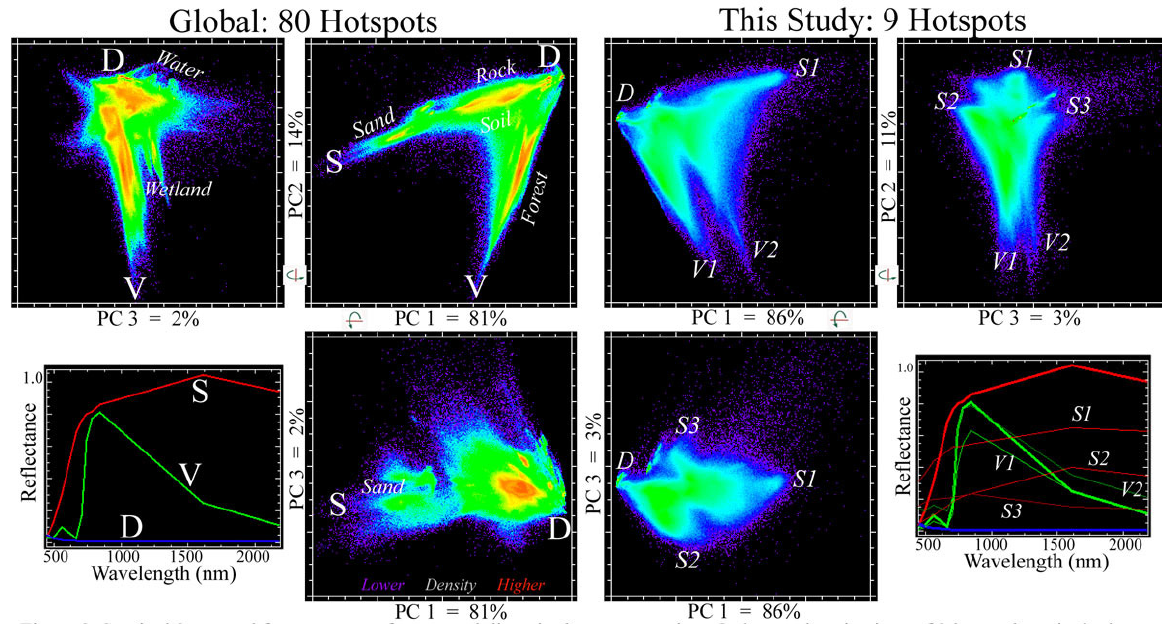
Figure 2. Sentinel 2 spectral feature spaces for spectral diversity hotspot mosaics. Orthogonal projections of three low-order principal component distributions are bounded by substrate, vegetation, and dark spectral endmembers at apices spanning spectral mixtures within the triangular space. The 9X larger, more diverse global mosaic has a more distinct internal structure with multiple clusters and mixing continua denoting different types of land cover. Both spaces are effectively 2D, with >95% of variance on the PC1-2 plane. Axes of rotation are indicated by arrows.